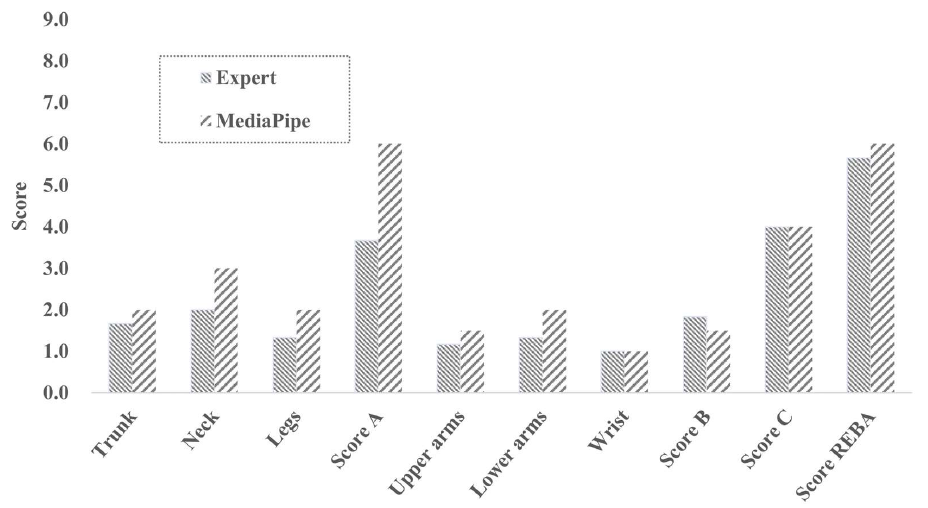
Figure 39. Comparison of chisel working posture scores.